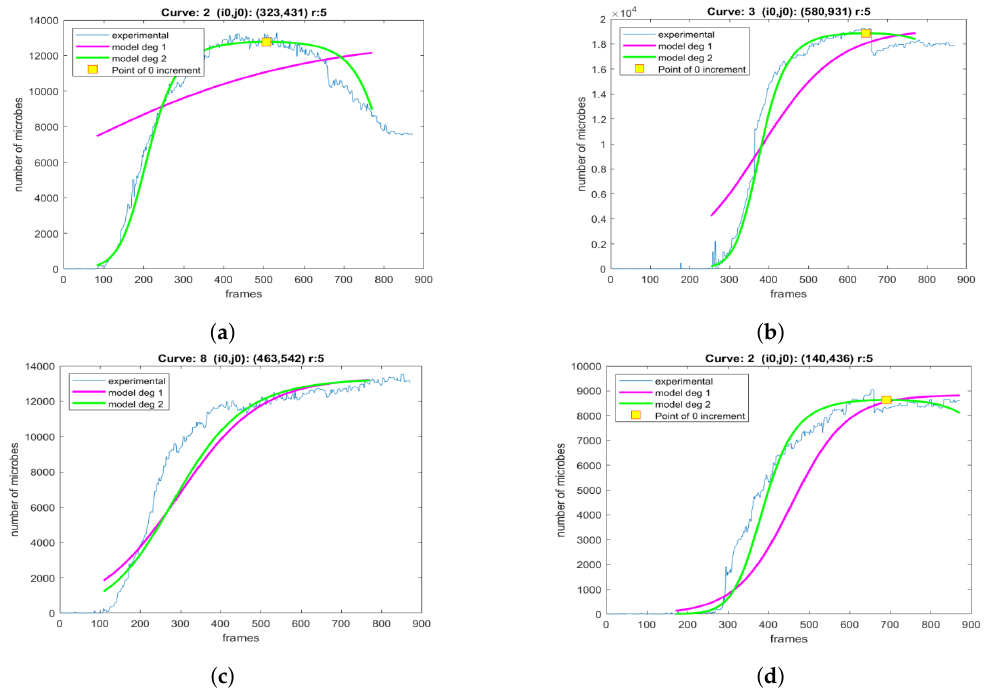
Figure 16. The modeling of the generated experimental curves with LF and LFSD for area of size r = 5, around the central point. The curves are extracted from locations marked as ( a ) A, ( b ) B, ( c ) C, and ( d ) D on the final frame of the petri dish